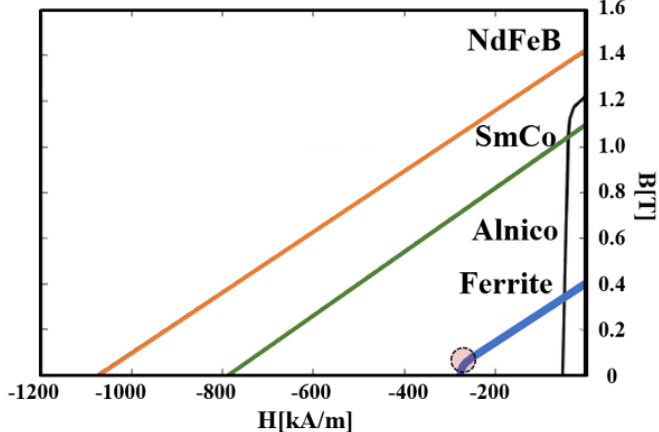
Figure 2. Comparison of B − H curves among different PM materials.